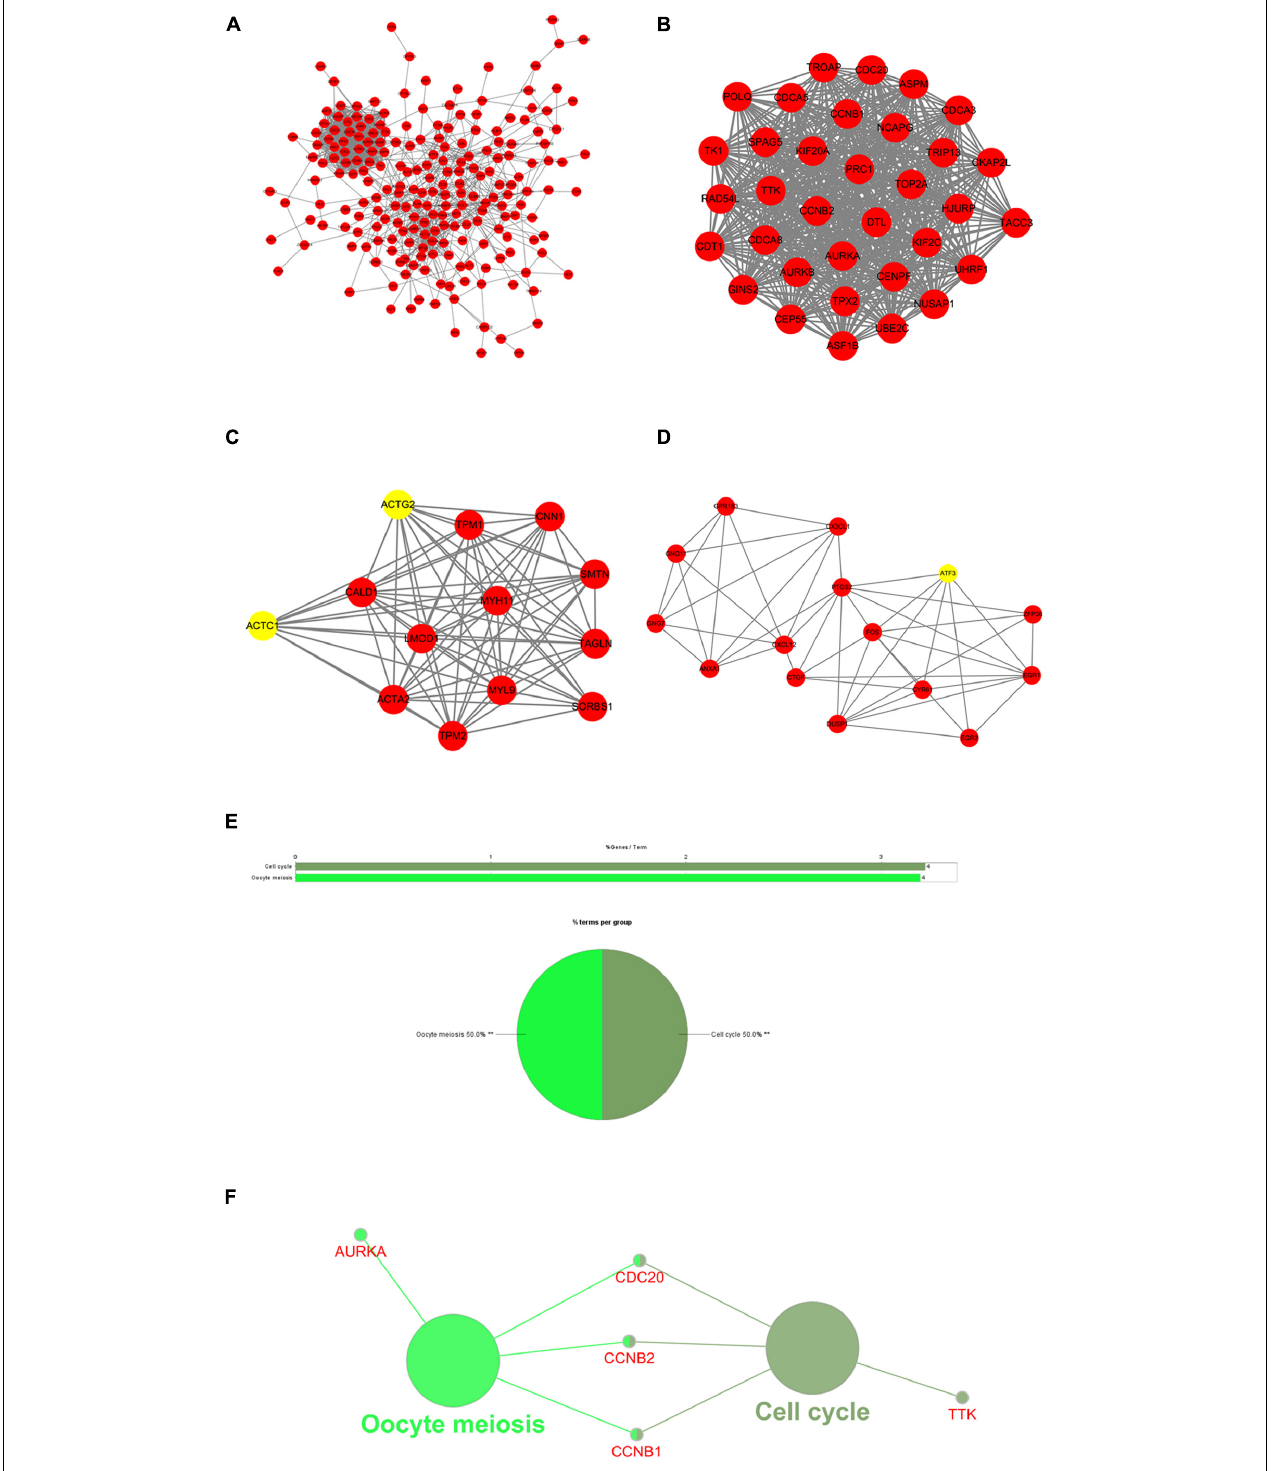
FIGURE 3 | Protein–protein interaction (PPI) network and results of module analysis. (A) The PPI network of common differentially expressed genes (DEGs) in GSE13507 and The Cancer Genome Atlas Urothelial Bladder Carcinoma (TCGA-BLCA). (B) Module 1, MCODE score = 33.03. (C) Module 2, MCODE score = 12.167. (D) Module 3, MCODE score = 6.429 (yellow nodes are seed genes in the network; MCODE score refers to the score of each module to evaluate the degree of clustering). (E) Overview of the enrichment analysis of Module 1. (F) A functionally grouped network of terms, in which node size indicates the richness of the term, and the functionally related genes partially overlap. **represents P <